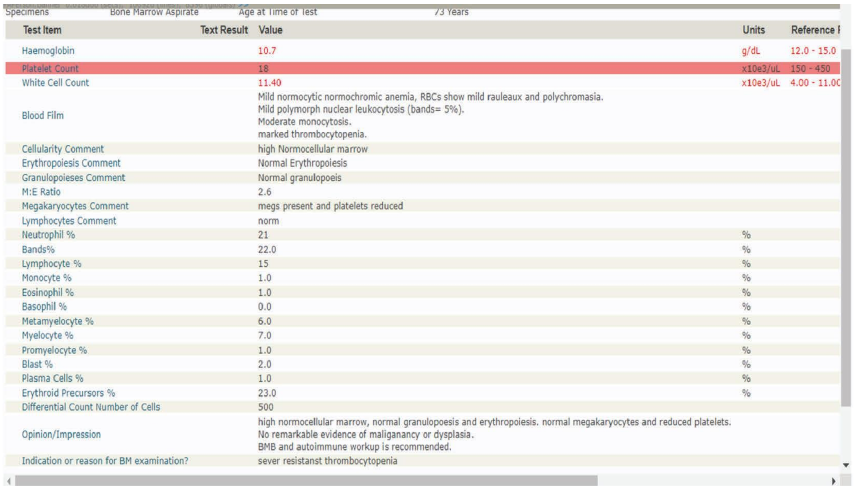
Figure 1: Initial laboratory results for CBC.